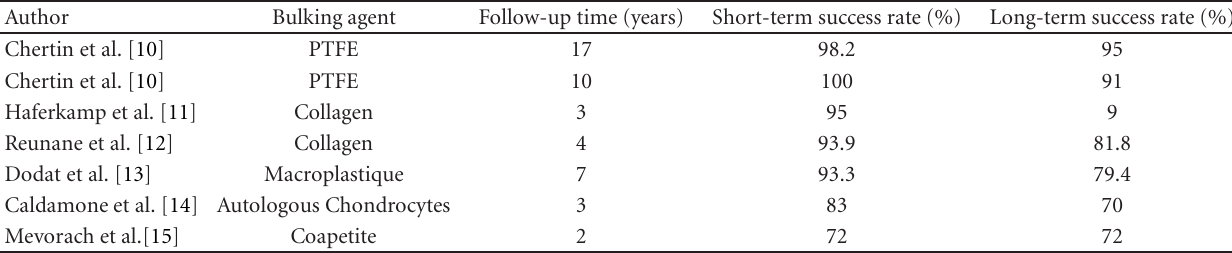
Table 1: Long-term results of endoscopic treatment of